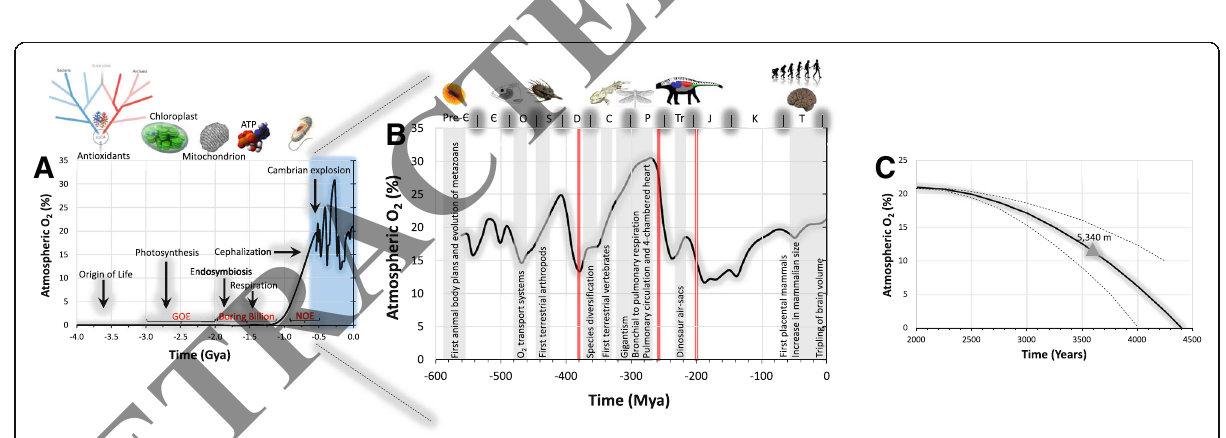
Fig. 1 Coupled evolution of life and atmospheric oxygen. Major evolutionary and developmental events that have been linked to “ pulses ” in the atmospheric oxygen (O 2 ) concentration based on the GEOCARBSULPH model (Berner 2007; Berner 2009). a Note that since the origin of life within 500 million years of Earth ’ s formation (LUCA, Last Universal Common Ancestor), oxygenic photosynthesis was responsible for the rapid increase in atmospheric O 2 levels during the Proterozoic Eon of the Pre-Cambrian period (~ 0 – 10% in < 1 billion years) preceded by endosymbiosis, emergence of cellular respiration with adenosine triphosphate the universal energy source and cephalization, a characteristic feature of the ancestral bilateria, leading to the first appearance of a central nervous system (Holland et al. 2013). Pre- Є , Pre-Cambrian; Є , Cambrian; O, Ordovician; S, Silurian; D, Devonian; C, Carboniferous; P, Permian; Tr, Triassic; J, Jurassic; K, Cretaceous; T, Tertiary. b Stochastic changes in atmospheric O 2 levels during the Phanerozoic eon peaked during the Carboniferous/Permian periods resulting in gigantism subsequent to augmented O 2 diffusive capacity and heralded major evolutionary advances that included a 3.5-fold increase in hominin brain volume over ~ 2.75 million years (Seymour et al. 2016). Also note the three major extinction events (red bands) associated with dramatic falls in atmospheric O 2 levels. c Parabolic projection of the decline in future atmospheric O 2 levels using a stochastic model (Livina et al. 2015) applied to original data obtained from recording stations in the Scripps Programme (Keeling 1988). Note that the model predicts that in ~ 3,600 years, atmospheric O 2 levels will be so low that hypoxia will be encountered even at sea-level, equivalent to being exposed to a terrestrial altitude of ~ 5,340 m which represents the highest elevation know to sustain lifelong human habitation with complete (O 2 ) depletion predicted within ~ 4.4 millennia (Martin et al.